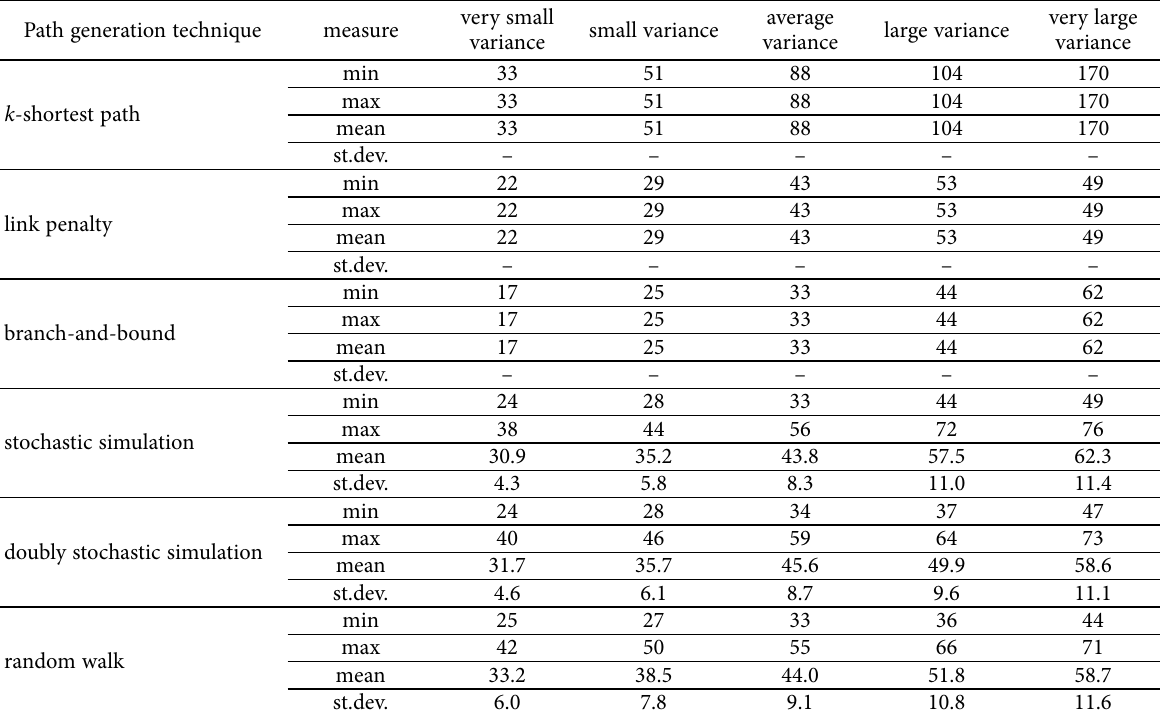
Table 2. Summary of characteristics of generated choice sets